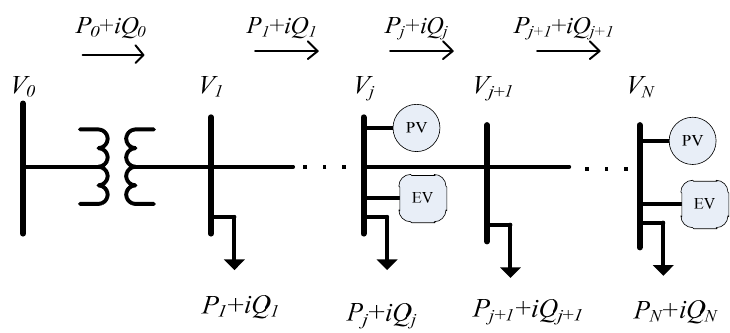
Figure 3. A branch in a radial distribution